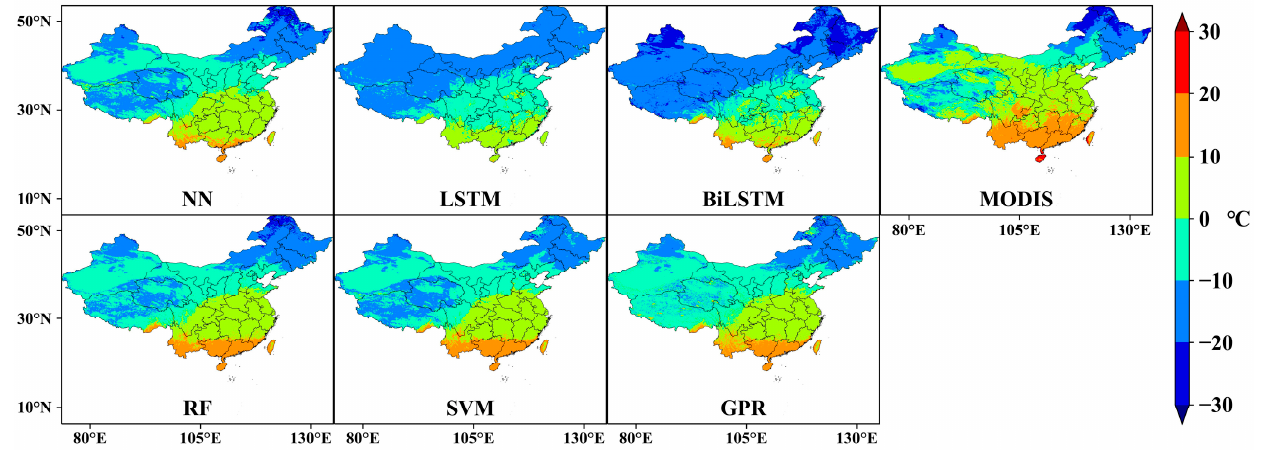
Figure 12. The NLSAT estimation results for the winter of 2015.